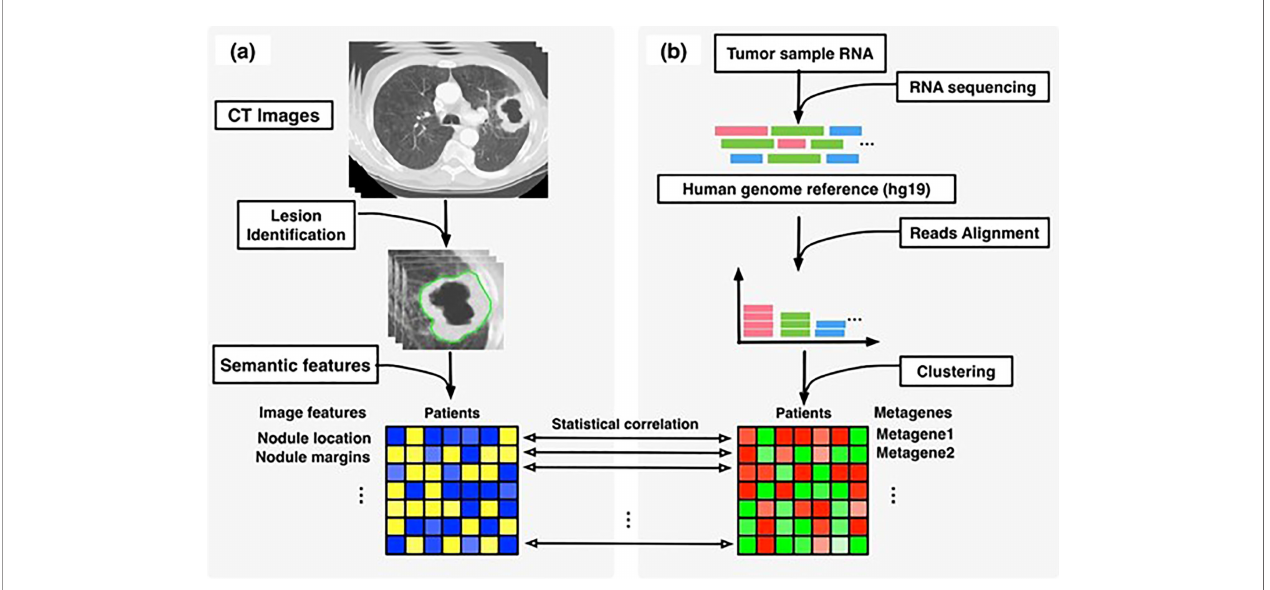
FIGURE 1 | Overview of radiogenomic analysis to identify associations between, (A) semantic features at CT and, (B) RNA sequencing data. [reused from Zhou et al. (24) under the CC-BY